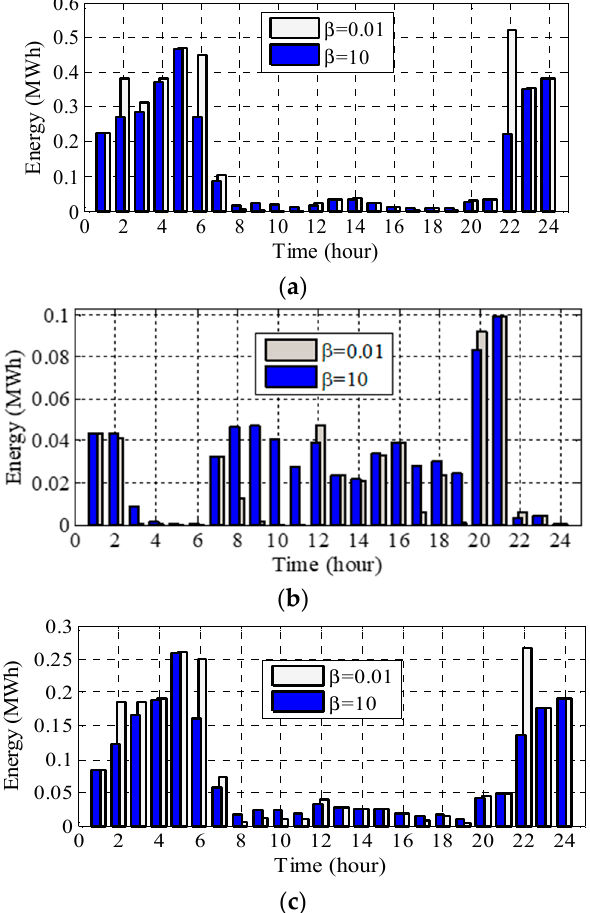
Figure 5. The expected energy procurement from ( a ) day-ahead; ( b ) positive; ( c ) negative balancing markets for two risk-aversion factors, β = 0.01 and 10.